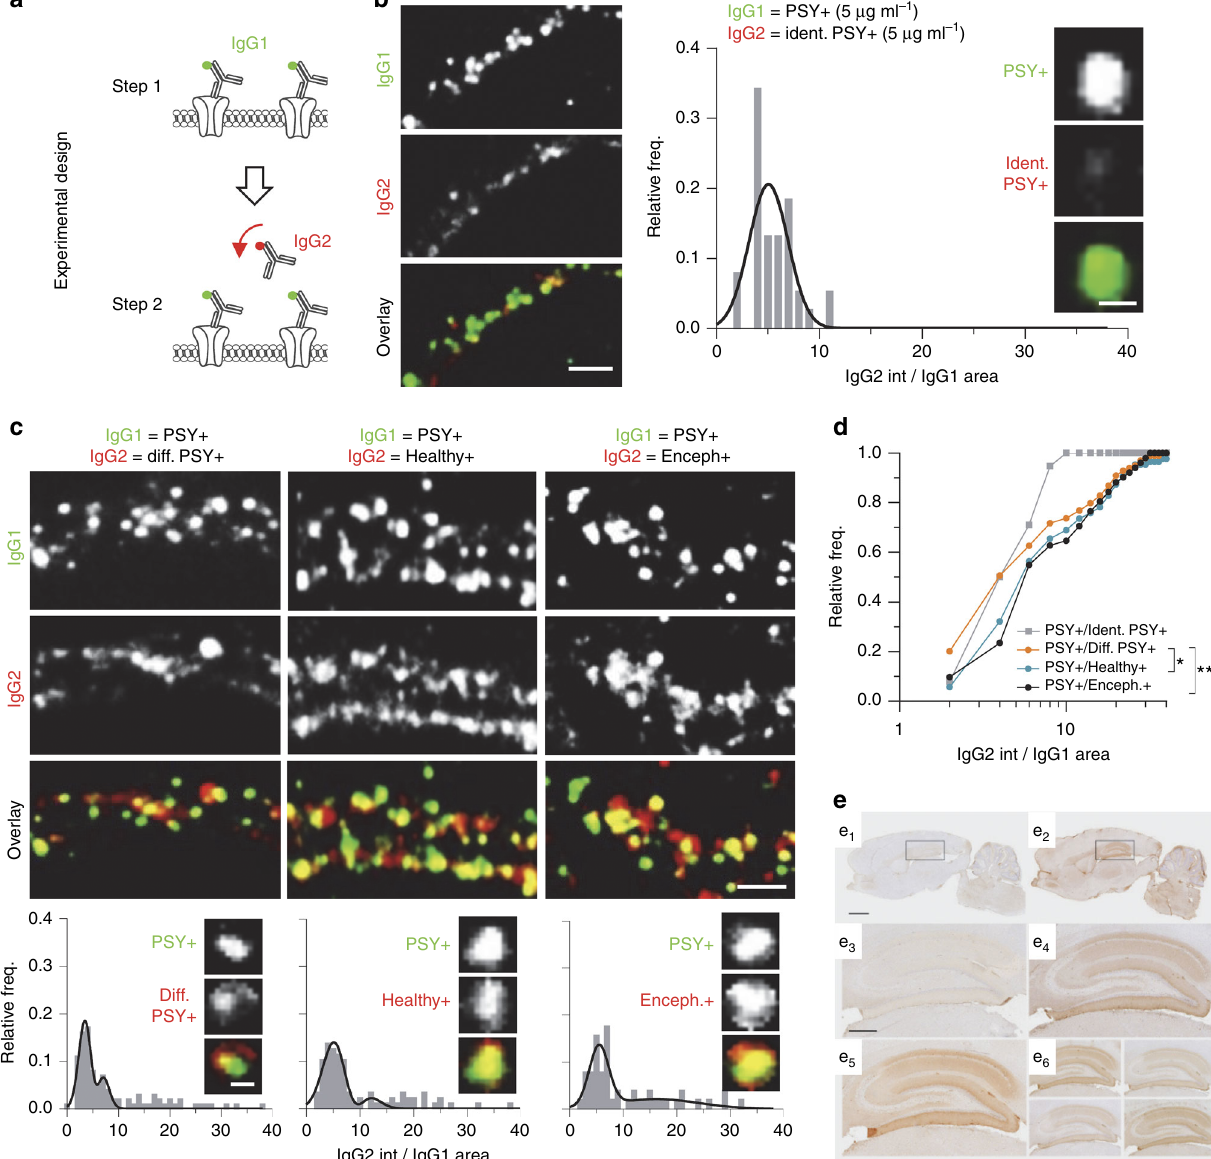
Fig. 2 NMDAR-Ab from different origins target do not compete for target binding. a Experimental design of the in vitro immuno-competition test. Hippocampal cultures (12 div) were fi rst incubated with PSY + NMDAR-Ab (IgG1) labeled in green. Cells were then incubated with a second Healthy + , PSY + or Enceph + IgG (IgG2) labeled in red. Three out of three Healthy + , four out of nine PSY + , and one out of seven encephalitis puri fi ed IgG samples were used and pooled for comparisons. b Representative dendritic areas labeled with PSY + NMDAR-Ab (IgG1, 5 µ g ml − 1 , green) and treated with the same IgG (IgG2 = ident. PSY + , 5 µ g ml − 1 , red). Scale bar, 2 µ m. Right panel: histogram of IgG2 fl uorescence intensity within IgG1 area. The use of the same IgG (IgG2 = ident. PSY + ) results in a distribution fi tted with a single Gaussian. Insets, staining from a single cluster. Scale bar, 500 nm. c Representative dendritic areas labeled with a PSY + NMDAR-Ab (IgG1, 5 µ g ml − 1 , green) and treated with NMDAR-Ab from another PSY + patient (IgG2 = Diff. PSY + ), a healthy individual (IgG2 = Healthy + ) or a patient with anti-NMDAR encephalitis (IgG2 = Enceph + ). Scale bar, 2 µ m. Bottom panels: Corresponding histograms of IgG2 fl uorescence intensity within IgG1 area for the different competing conditions. Insets, staining from single clusters. Scale bar, 500 nm. d Cumulative distributions of IgG2 intensity within IgG1 cluster areas according to the different competing conditions: PSY + /Ident. PSY + ( n = 38 dendritic regions, N = 10 neurons), PSY + /Diff. PSY + ( n = 99, N = 32), PSY + /Healthy + ( n = 78, N = 26) or PSY + /Enceph + ( n = 51, N = 15); * P < 0.05, ** P < 0.005, Kolmogorov – Smirnov test. e Competing biotinylation assay in rat hippocampal slices. Pre-incubation of rat brain sections with serum from a patient with anti-NMDAR encephalitis blocks the reactivity of biotinylated IgG from another patient with anti-NMDAR encephalitis (left and middle panels). Pre- incubated with serum from a healthy control does not block the reactivity of biotinylated IgG from a patient with anti-NMDAR encephalitis (e2 and e4). Pre-incubation of sections of rat brain with serum of fi ve patients with schizophrenia does not block the reactivity of biotinylated IgG from a patient with anti-NMDAR encephalitis (e5 and